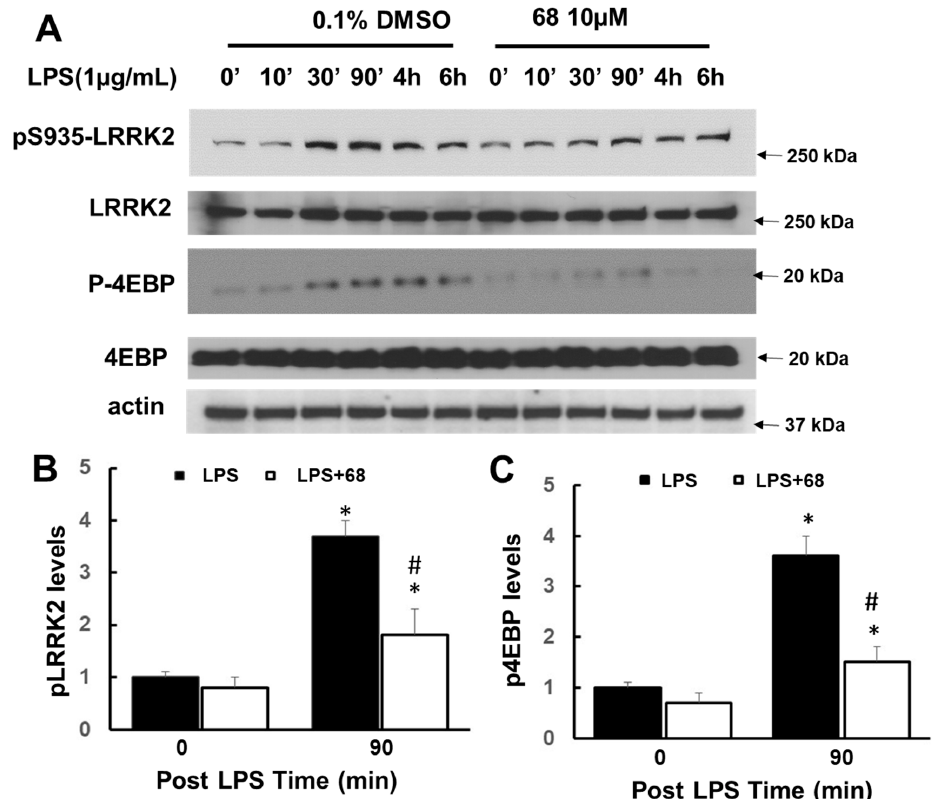
Figure 2. Compound 68 reduced lipopolysaccharide (LPS)-induced LRRK2 kinase activity. Human lymphoblasts were incubated in serum-free medium for 12 h and then exposed to LPS (1 µg/mL) with or without pre-treating 68 (10 µM) for 2 h, then kept treatment for various time periods as indicated. Cell lysates were harvested at the indicated time points after LPS exposure, then were subjected to immunoblot analysis using the indicated antibodies. ( A ) Representative blots from at least three separate experiments. ( B , C ) The quantification of phosphorylated pLRRK2 ( B ) and p4EBP ( C ) levels at 90 min, peak time. * p < 0.05 by ANOVA, vs. untreated cells. # p < 0.05 by ANOVA, vs. cells at 90 min post LPS exposure.